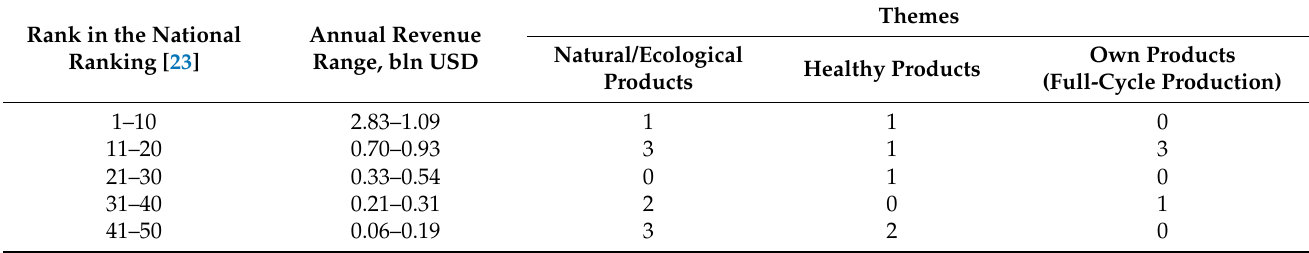
Table 2. Supplementary themes in the groups of agroholdings with different